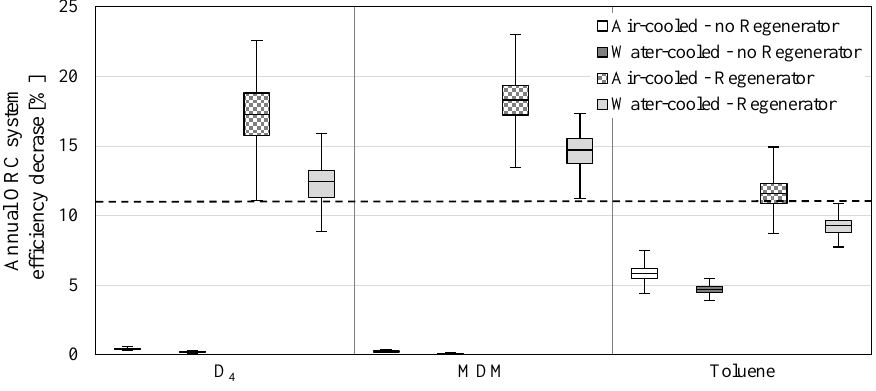
Figure 14. Annual ORC system efficiency decrease due to decrease in leaving exhaust gas